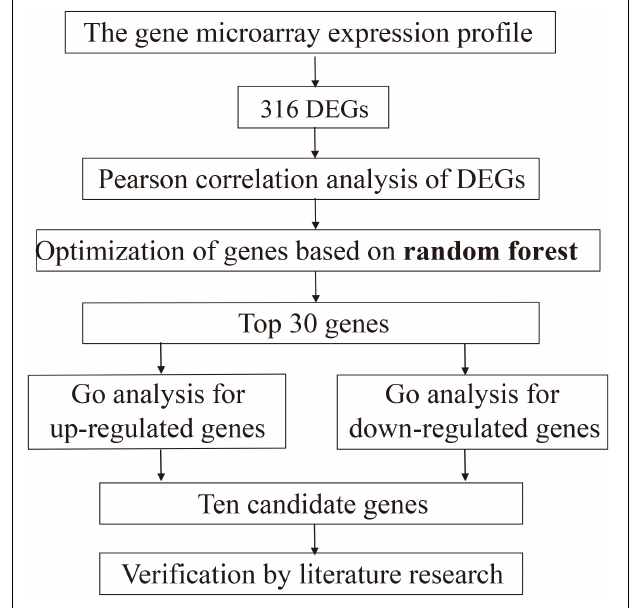
FIGURE 1 | The overall